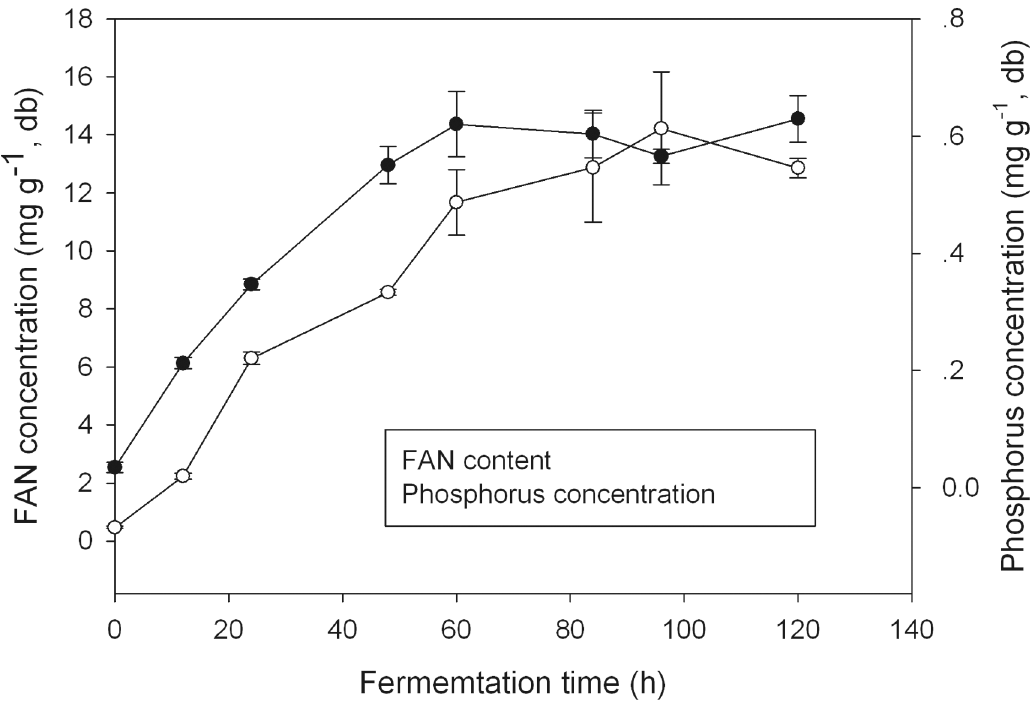
Fig 4. The contents of free amino nitrogen and inorganic phosphorus in N . crassa derived hydrolysate. The rapeseed meal was fermented with N . crassa J2 at 30°C and sampled at various time points for analytical experiments; Data are means and standard deviations from triplicate fermentations.